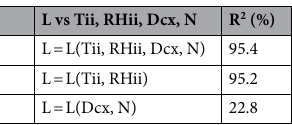
Table 3. Correlation between the different variables studied.